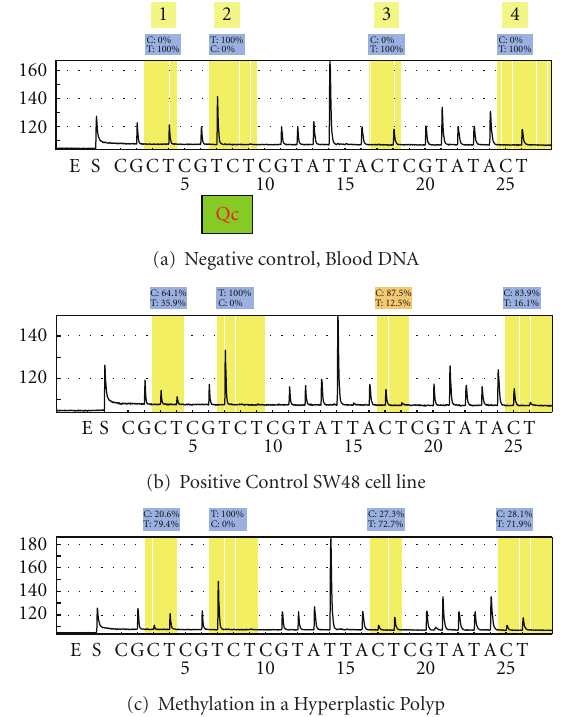
Figure 2: Pyrograms for MINT 1. (a) Represents unmethylated control bisulfite modified DNA. Position 2 represents the quality control loci and should remain negative for Cs. It can be seen that all Cs within the CpG islands at positions 1, 3, and 4 also reveal no Cs, that is, the DNA is unmethylated. In contrast, pyrogram B which represents a positive control from the SW48 cell line, position 2 remains negative for Cs, but the CpG’s at position 1, 3, and 4 have 64.1%, 87.5%, and 83.9% methylation, respectively. This positive control as anticipated is methylated. The final sample in C represents DNA extracted from a hyperplastic polyp. This demonstrates 20.6%, 27.3%, and 28.1% methylation at position 1, 3, and 4, respectively, with a negative result for the internal control at position